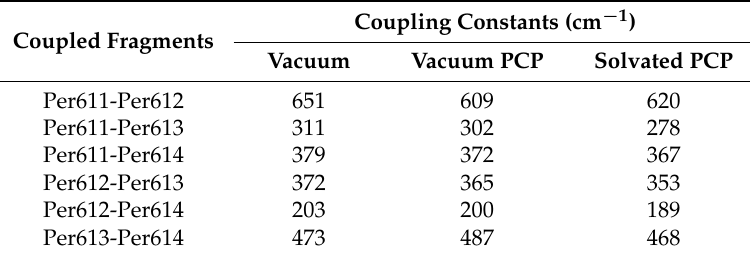
Table 3. Comparison of Per-Per interaction strengths in different environments.